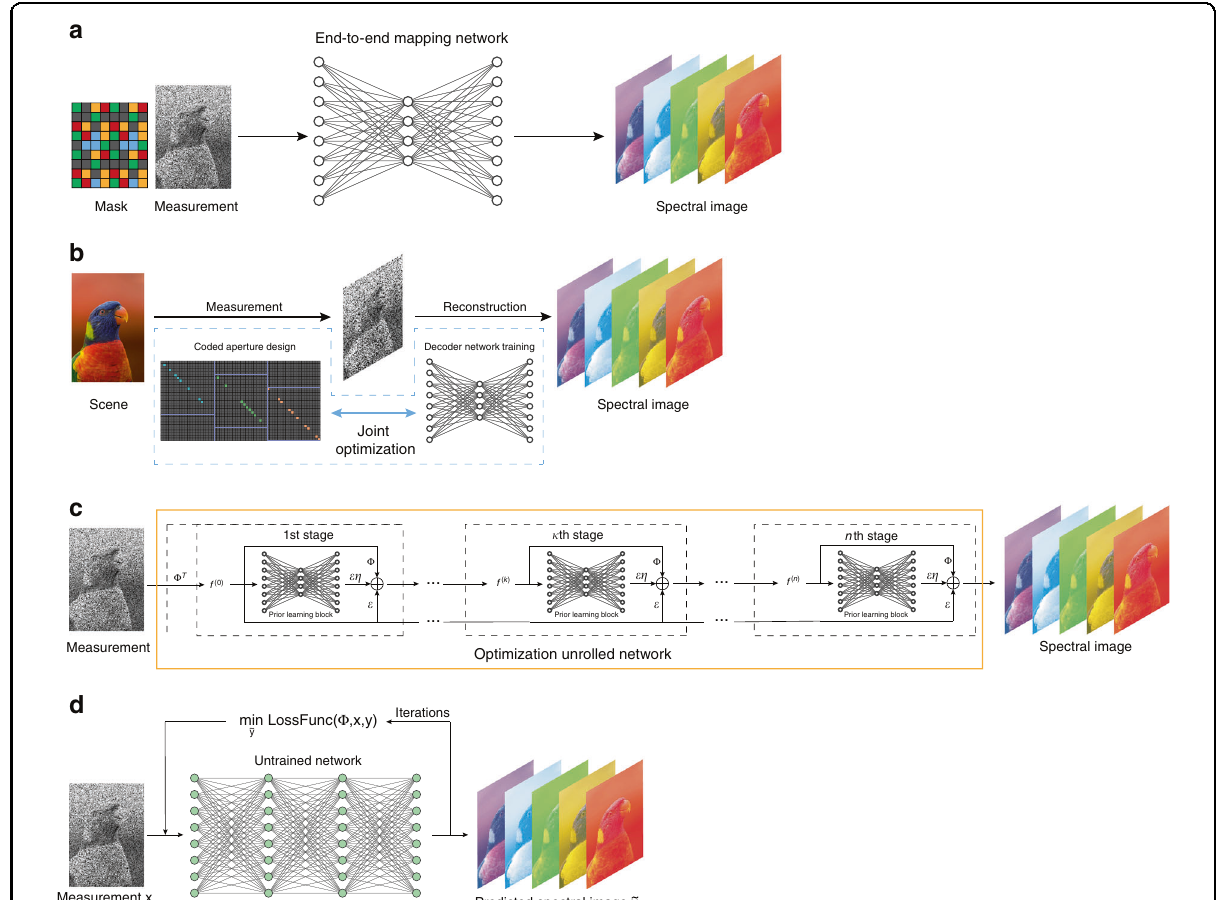
Fig. 5 Main ideas of the four deep compressive reconstruction approaches. a End-to-end reconstruction. b Joint mask learning. c Unrolled network. d Untrained